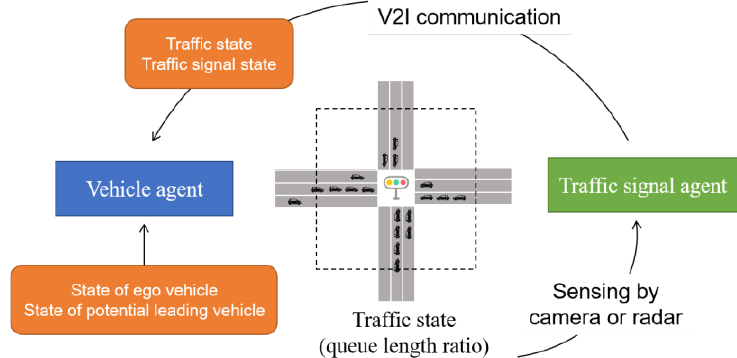
Figure 5. The state description of each kind of agent.